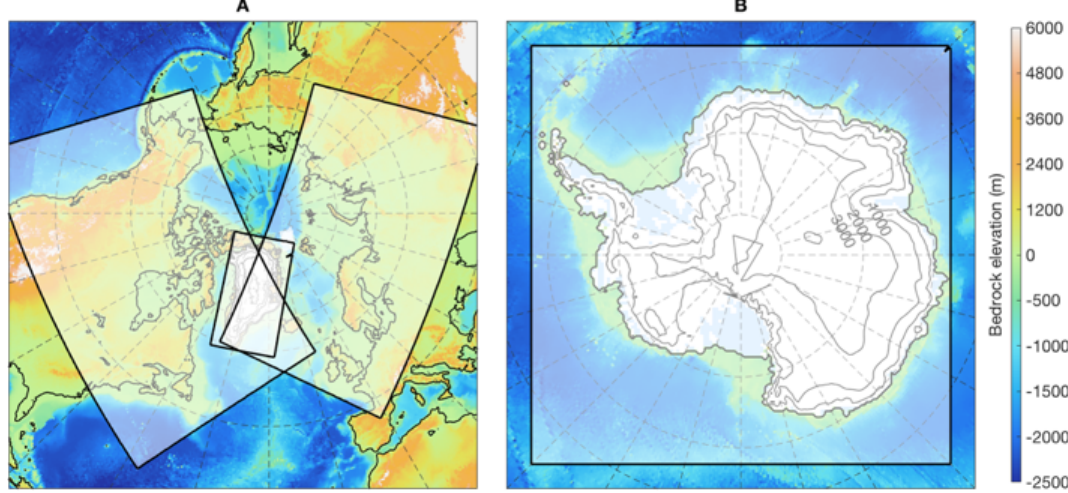
Figure 3. The areas of the world covered by the four model domains of ANICE. In the North America and Eurasia domains, Greenland is omitted. Figure adapted from Berends et al.